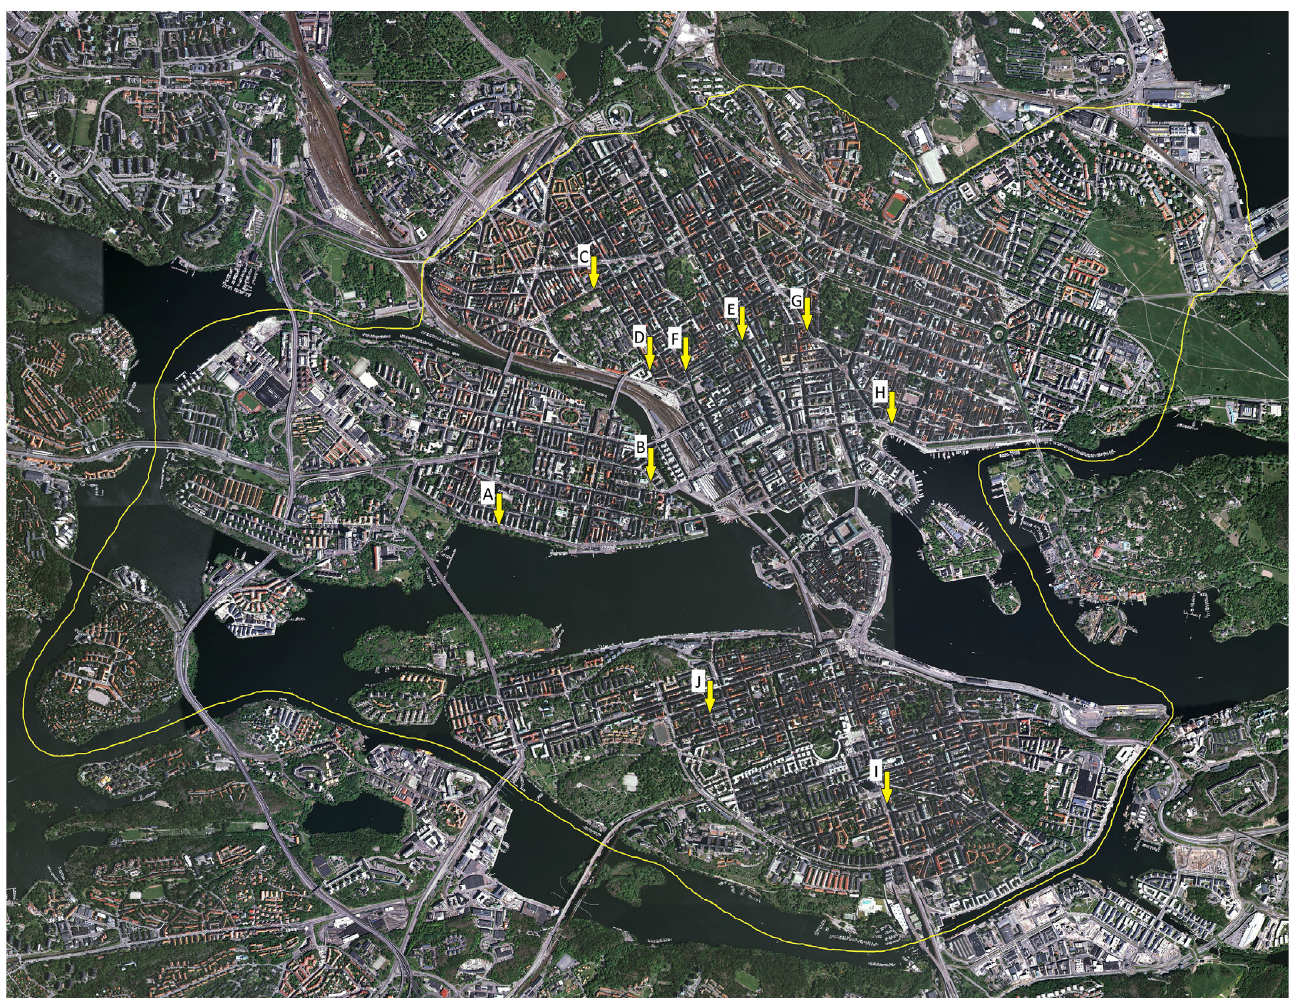
Figure A3. Aerial view of Stockholm from 2005 with the ten different selected roads (local streets, collector roads and minor arterials): ( A ) Norr Mälarstrand, ( B ) Kungsholmsgatan, ( C ) Odengatan, ( D ) Dalagatan, ( E ) Sveavägen, ( F ) Upplandsgatan, ( G ) Birger Jarlsgatan, ( H ) Sibyllegatan, ( I ) Götgatan, and ( J ) Rosenlundsgatan. These roads have lanes in both directions. The arrows mark the approximate location where the traffic measurement took place. The area inside the yellow line demarcates the inner urban study area. North is at the top of the image. (Copyright: Lantmäteriverket, Gävle, Sweden, 2011; Permission 81055230). Table A4. The VIF, the Cook´s distance and the standardized residuals.